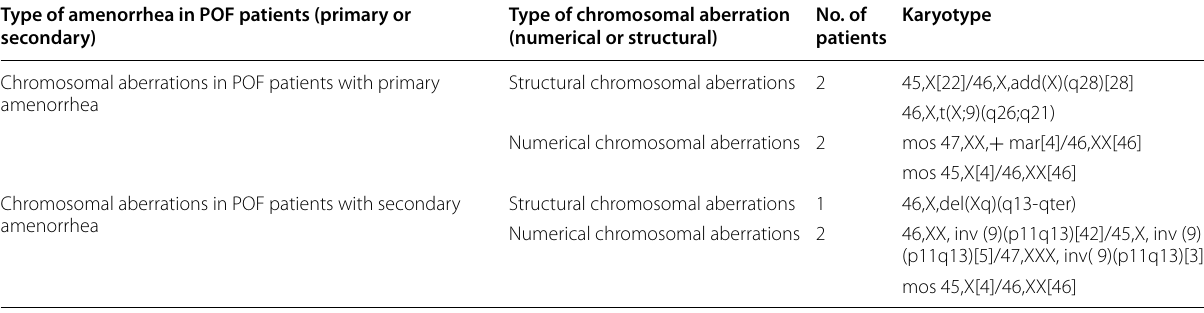
Table 3 Chromosomal aberrations in POF patients Type of amenorrhea in POF patients (primary or